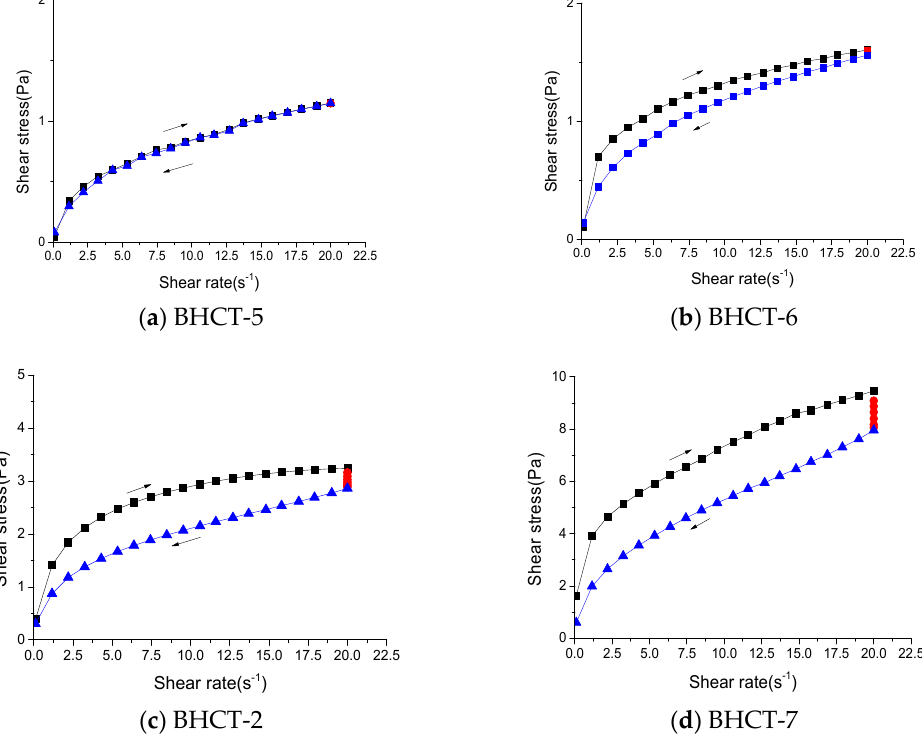
Figure 8. Viscosity curve of composite gel with different crosslinker concentrations.